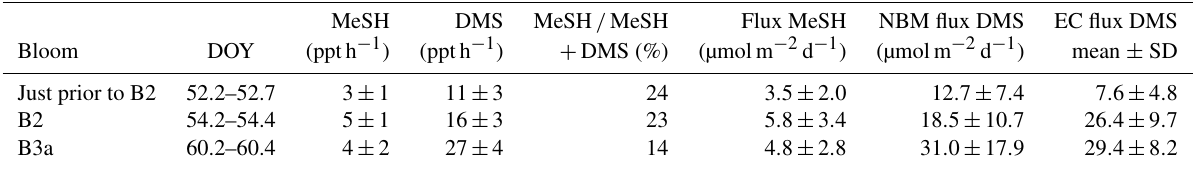
Table 4. MeSH and DMS fluxes calculated using the nocturnal buildup method (NBM) compared with DMS flux measured using the eddy covariance (EC) method (Bell et al., 2015). The ± values on the MeSH and DMS fluxes are due to the standard deviation (SD) of the MBL height. MeSH DMS MeSH / MeSH Flux MeSH NBM flux DMS EC flux DMS Bloom